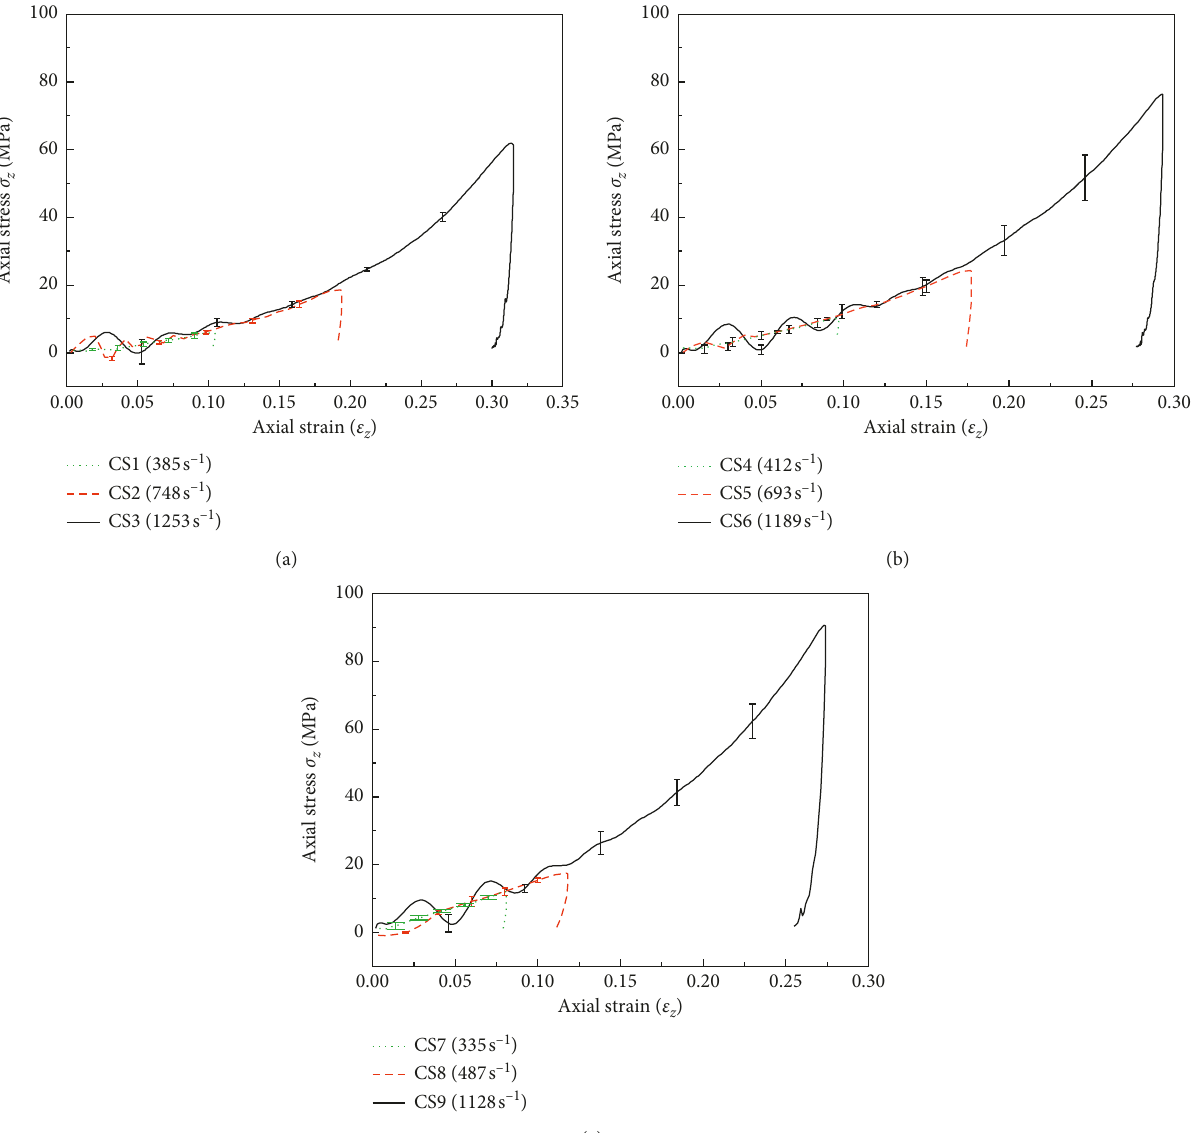
Figure 7: Effect of strain rate on the dynamic axial response of calcareous sand. The average axial strain-stress curves of calcareous sand with initial densities of (a) 1.26g/cm 3 , (b) 1.35g/cm 3 , and (c) 1.42g/cm 3